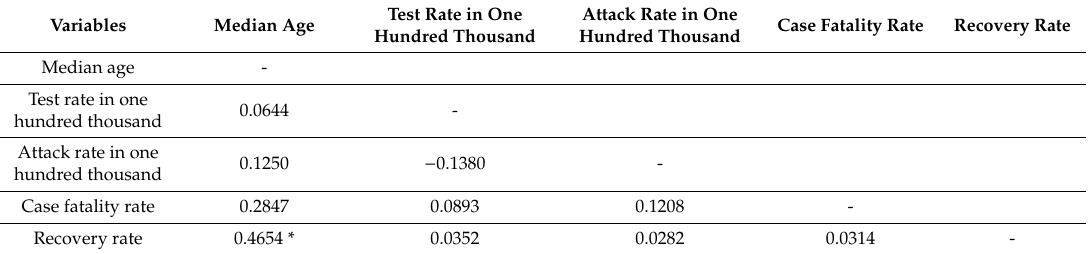
Table 2. Correlation analysis between median age and COVID-19 test, attack, fatality, and recovery rates.